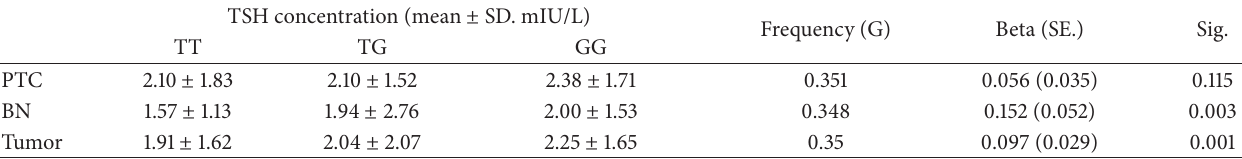
Table 4: Association between rs1204540 and the serum TSH concentrations adjusted to relevant